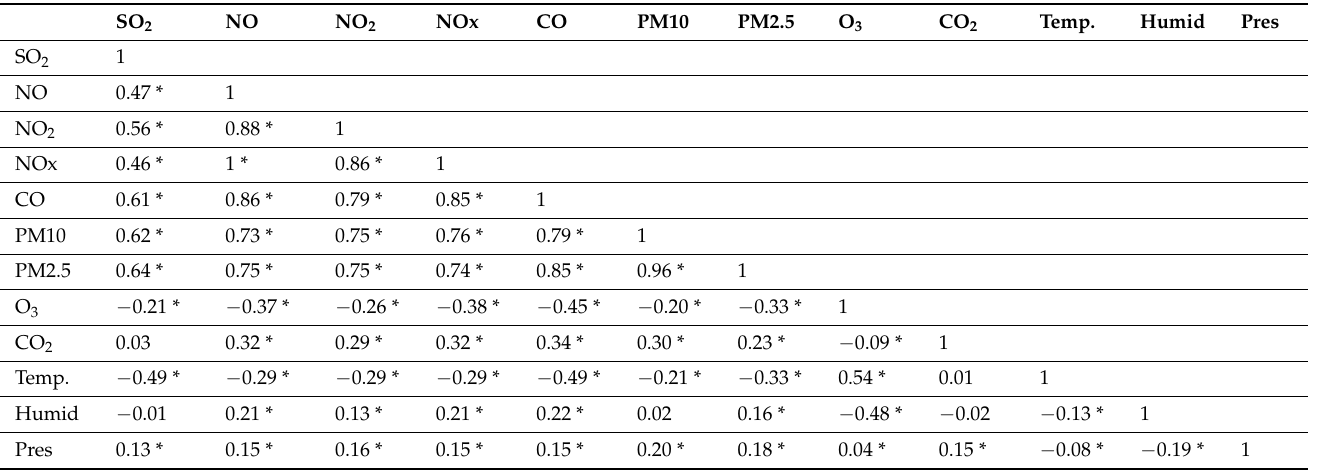
Table 3. Pearson correlation coefficients for air pollutants and meteorological variables. (* p value <